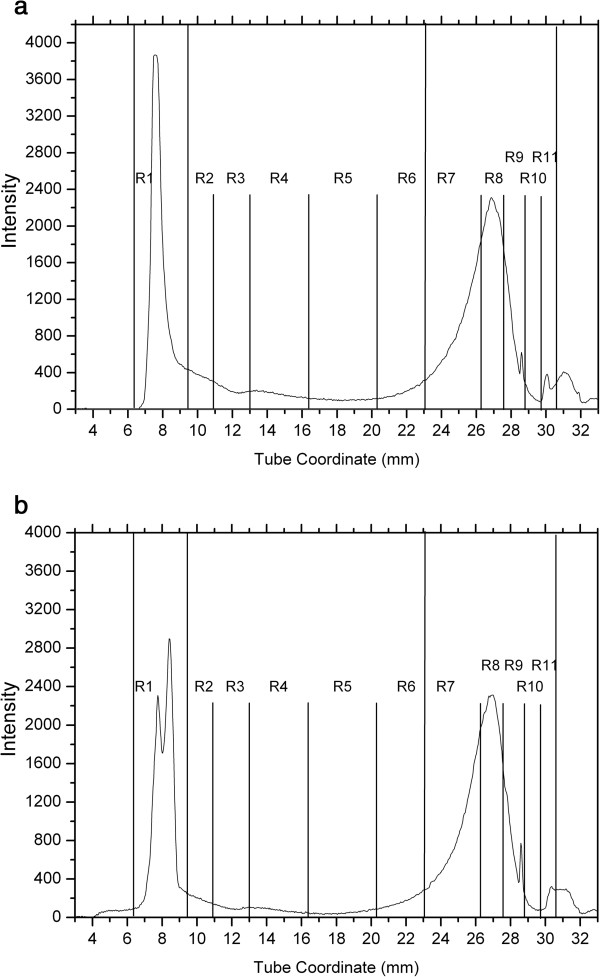
Representative continuous lipoprotein density profiles from 2 dogs (a and b) of group 2B (hyperlipidemic Miniature Schnauzers). As in dogs in groups 1 and 2A, fractions corresponding to nominal HDL densities (R7 to R11) were abundant while fractions corresponding to nominal LDL densities (R2 to R6) were low in this group. However, dogs of this group had prominent R1 peaks corresponding to the TRL area. Note the difference in the peak shapes of R1 fractions between the two dogs (a versus b).